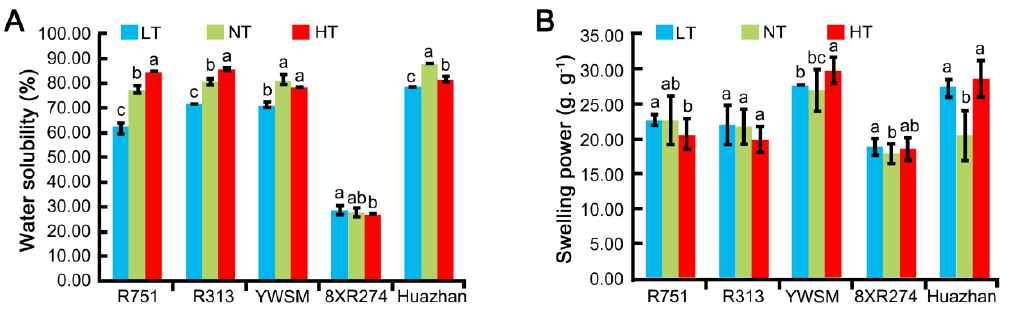
Figure 6. Water solubility index ( A ) and swelling power ( B ) of starch particles of the five restorer lines experiencing HT (high temperature), NT (normal temperature), and LT (low temperature) during the grain-filling stage. Data are shown as mean ± standard error of triplicate measurements. Different letters are added above standard deviation to express significant differences ( p < 0.05).